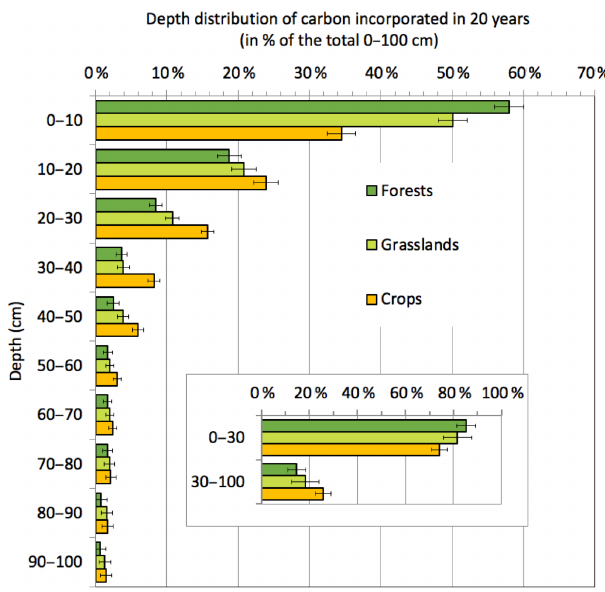
Figure 6. Vertical distribution of carbon incorporated by plant mat- ter in the soil in 20 years under average temperate conditions. The data are from the quantification of a recent incorporation of atmosphere-derived carbon atoms into whole-soil profiles through a meta-analysis of changes in stable carbon isotope signatures at 112 grassland, forest and cropland sites (across different climatic zones) from 1965 to 2015. The quantity (in 10cm increments) is expressed as a proportion of the total C incorporated in the first me- ter of soil. The value is a regression mean estimated from climate and land-use conditions. The error bars represent the 95% confi- dence interval of the estimate. (Based on data from Balesdent et al.,